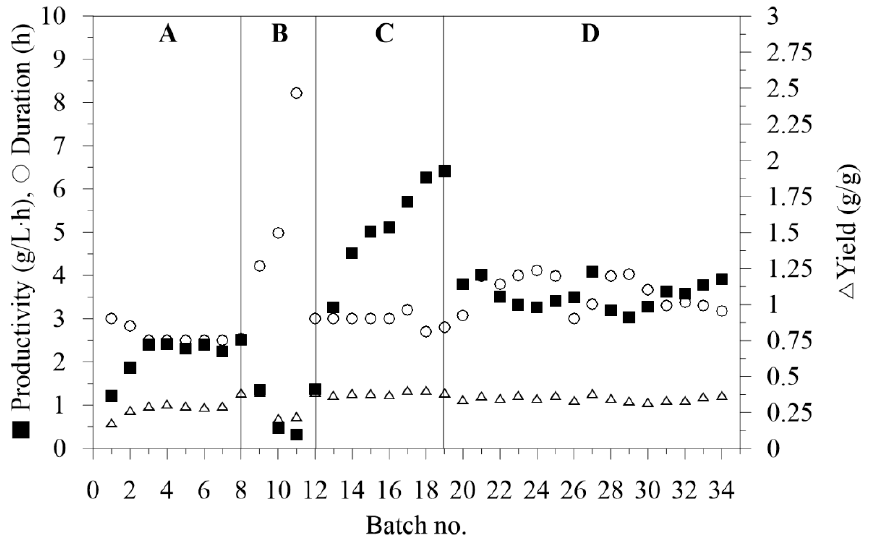
Figure 4. Productivity, fermentation time, and yield of 1,3-PD achieved in repeated consecutive fermentations of glycerol, at initial concentration 20.0 ± 0.2 g/L (A—UCO-derived crude glycerol), 41.5 ± 2.3 g/L (B—UCO-derived crude glycerol), 47.5 ± 1.5 g/L (C—pure glycerol for revitalization protocol), and 40.0 ± 1.2 g/L (D—RO-derived crude glycerol).